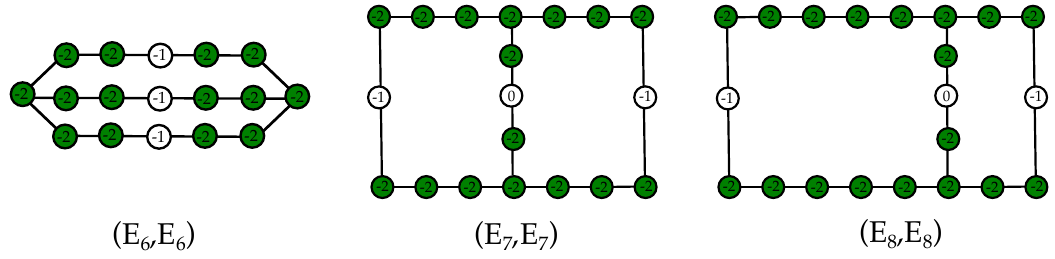
Figure 15 . The marginal CFDs for the (E n ; E n ), n = 5 ; 6 ; 7 minimal conformal matter theories.